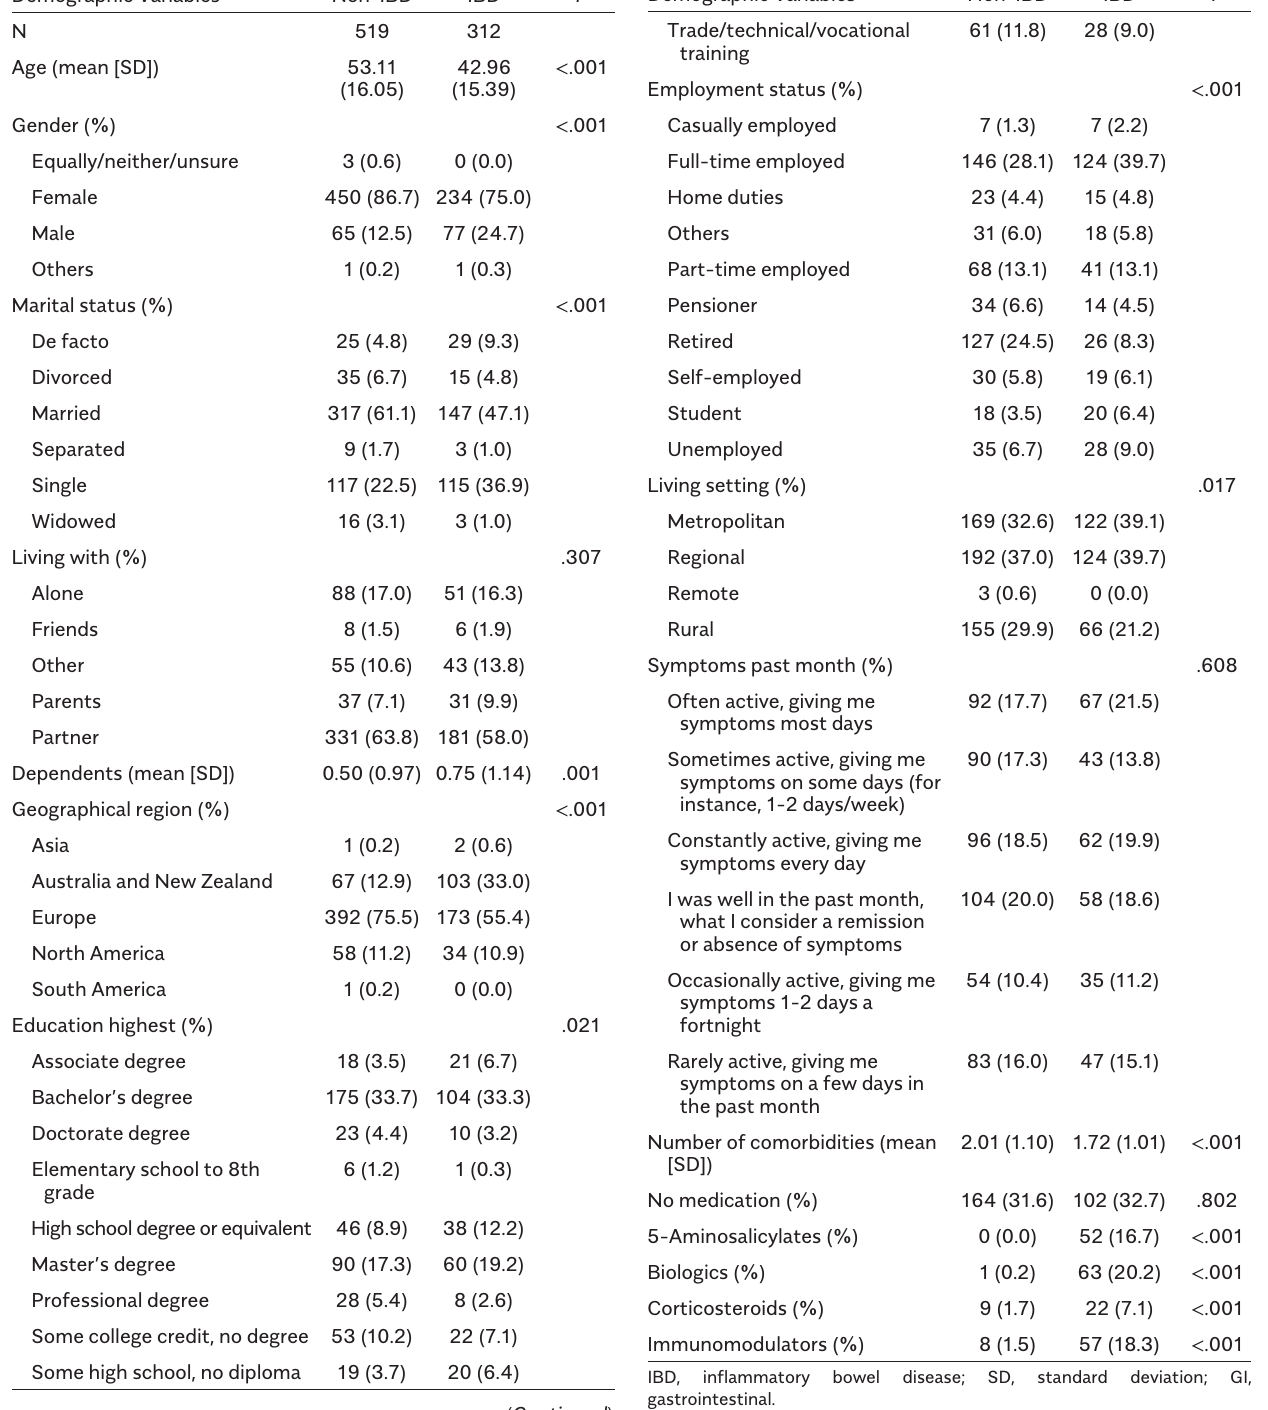
Table 1. Demographic Information Stratified by IBD Patients and Patients with Other GI Conditions Demographic